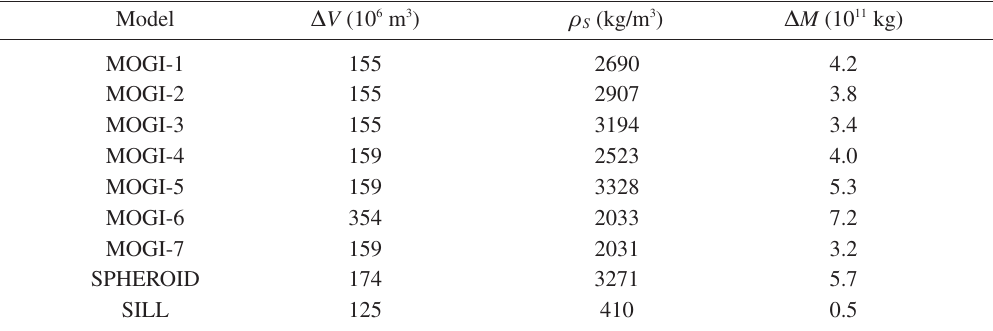
Table II. Volume variation and density calculated for each model (characteristics reported in table I) due to in- put of new mass within the cavity.